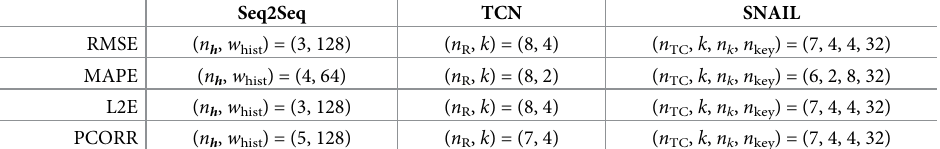
, the number of R ES B LOCK s n R , the number h = 4. k